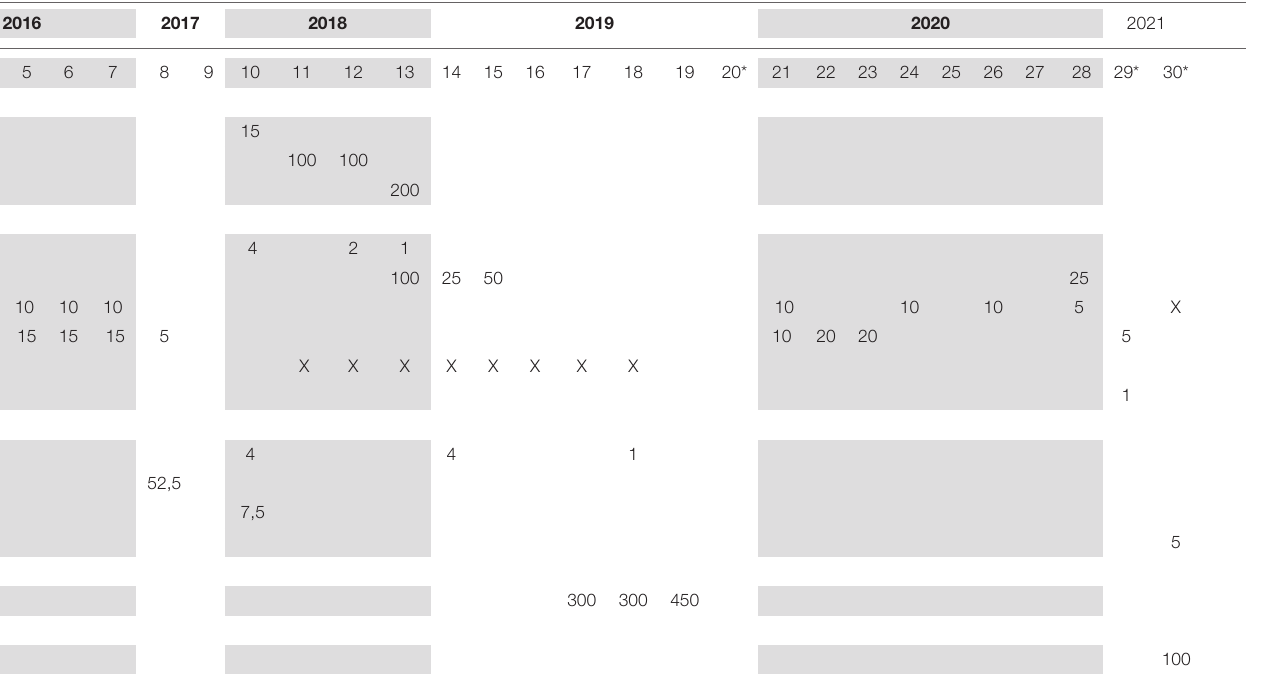
TABLE 2 | Prescribed medication at discharge over 8